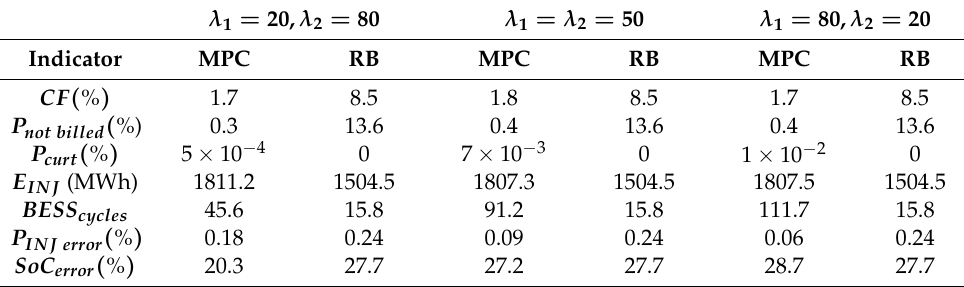
Figure 34. Zoom in the total power injected by the HPP into the Guadeloupe island electric grid using MPC/QP and rule-based algorithms in PowerFactory. Table 6. KPIs for comparison of MPC/QP and rule-based